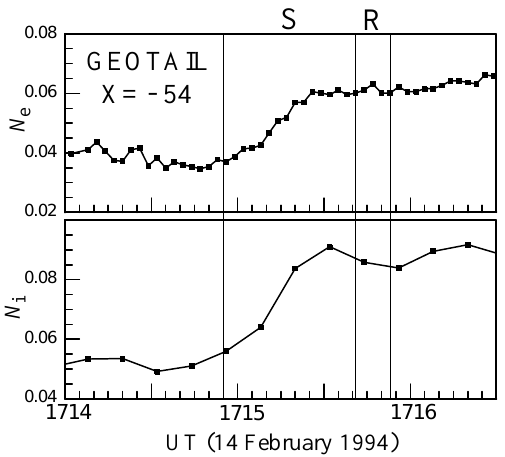
Fig. 3. The top panel shows the 3 s electron number density N e and the lower panel shows the 12 s average ion number density data. The plasma density increases monotonically across the slow shock layer.